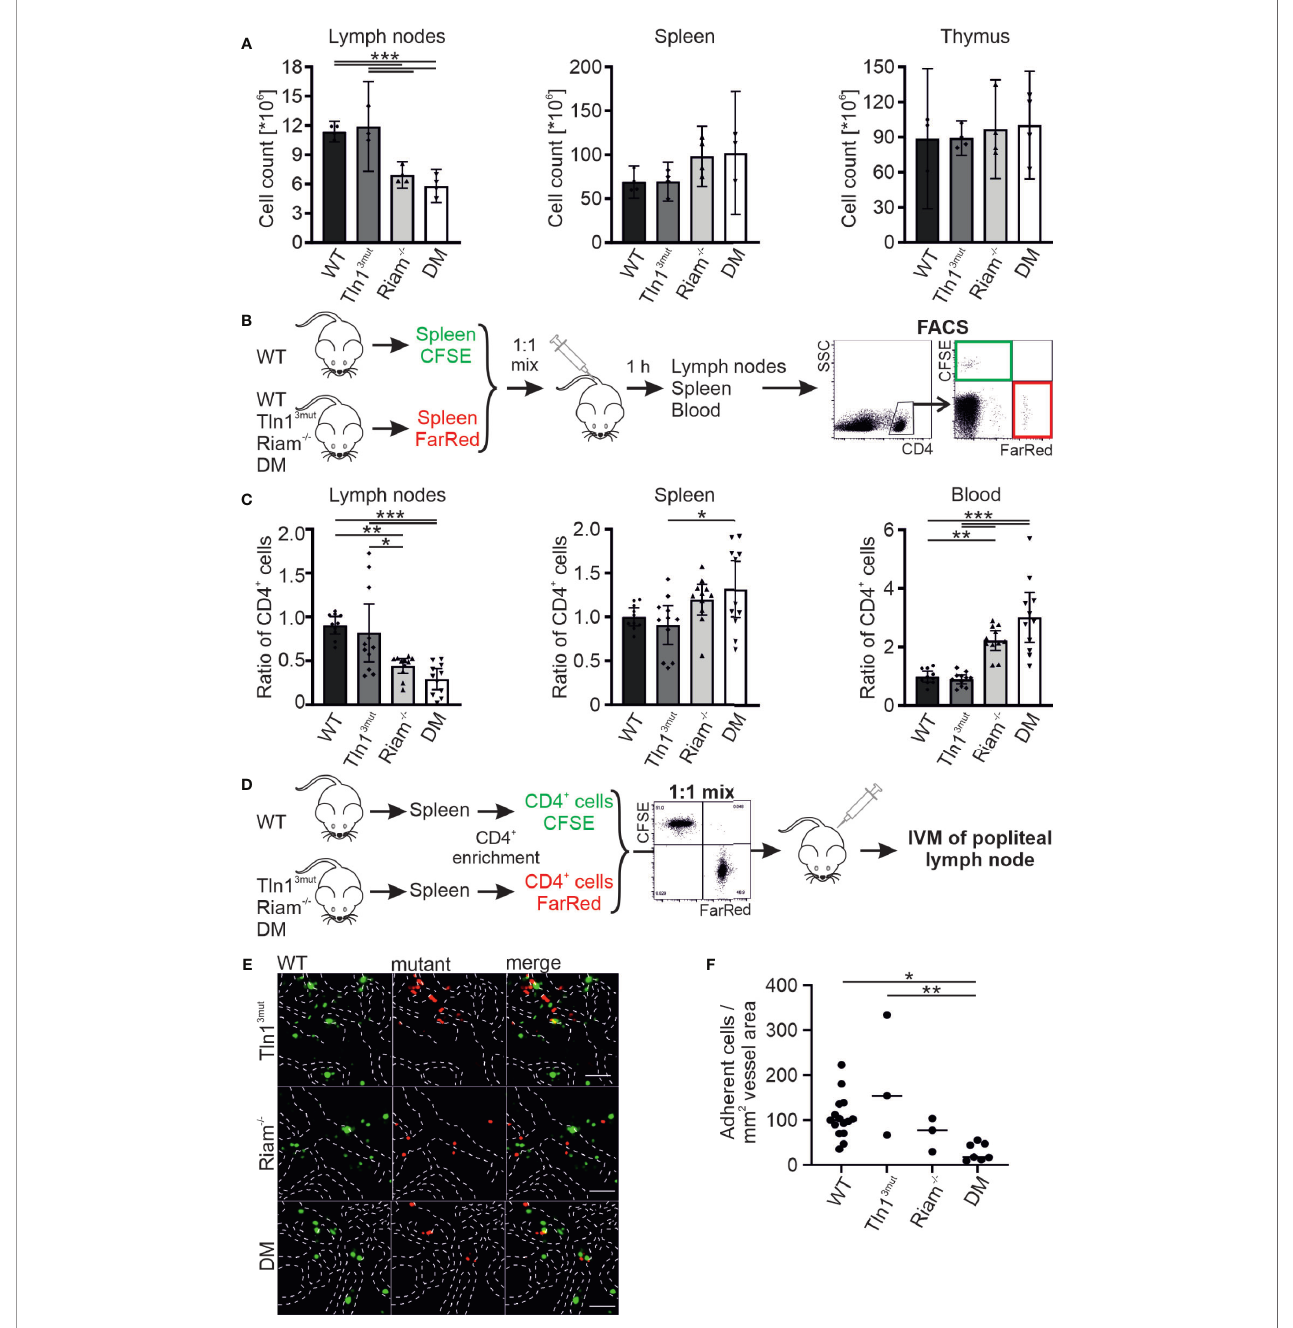
FIGURE 1 | The Rap1/talin and Rap1/Riam/talin pathways regulate T cell homing in vivo . (A) Cellularity of lymph nodes, spleens and thymi isolated from WT, Tln1 3mut , Riam -/- and DM mice (N = 4 mice). (B, C) T cell lymph node homing assessed in adoptive transfer experiments. A 1:1 mixture of CFSE-stained WT control and FarRed-stained WT, Tln1 3mut , Riam -/- or DM splenocytes (or swapped dyes) was injected into the tail vein of WT recipients. Ratios of CFSE and FarRed-stained CD4 + cells in different organs were measured 1 h after injection by FACS analysis. (C) Ratios of transferred WT, Tln1 3mut , Riam -/- and DM to control cells obtained in lymph nodes, spleen and blood of recipient animals (N = 10/11/11/11). (D – F) Adhesion of CD4 + T cells assessed in vivo by confocal intravital microscopy of the lymph node vasculature after adoptive transfer. (D) Schematic overview of the experiment. Recipient animals were injected with a 1:1 mix of CFSE stained WT and FarRed stained Tln1 3mut , Riam -/- or DM pre-enriched CD4 + T cells (or swapped dyes) and subjected to intravital microscopy. (E) Exemplary confocal images of WT (green) and Tln1 3mut , Riam -/- or DM (red) cells in the popliteal lymph node vasculature. Blood vessel borders are highlighted by dashed white lines, scale bars: 50 µm. (F) Number of adherent cells normalized by the blood vessel surface area (N=12/3/3/6). All values are given as mean ± 95% con fi dence interval. Statistical signi fi cance was assessed using One-way ANOVA followed by Tukey ’ s multiple comparison test. *p < 0.05, **p < 0.01, ***p <